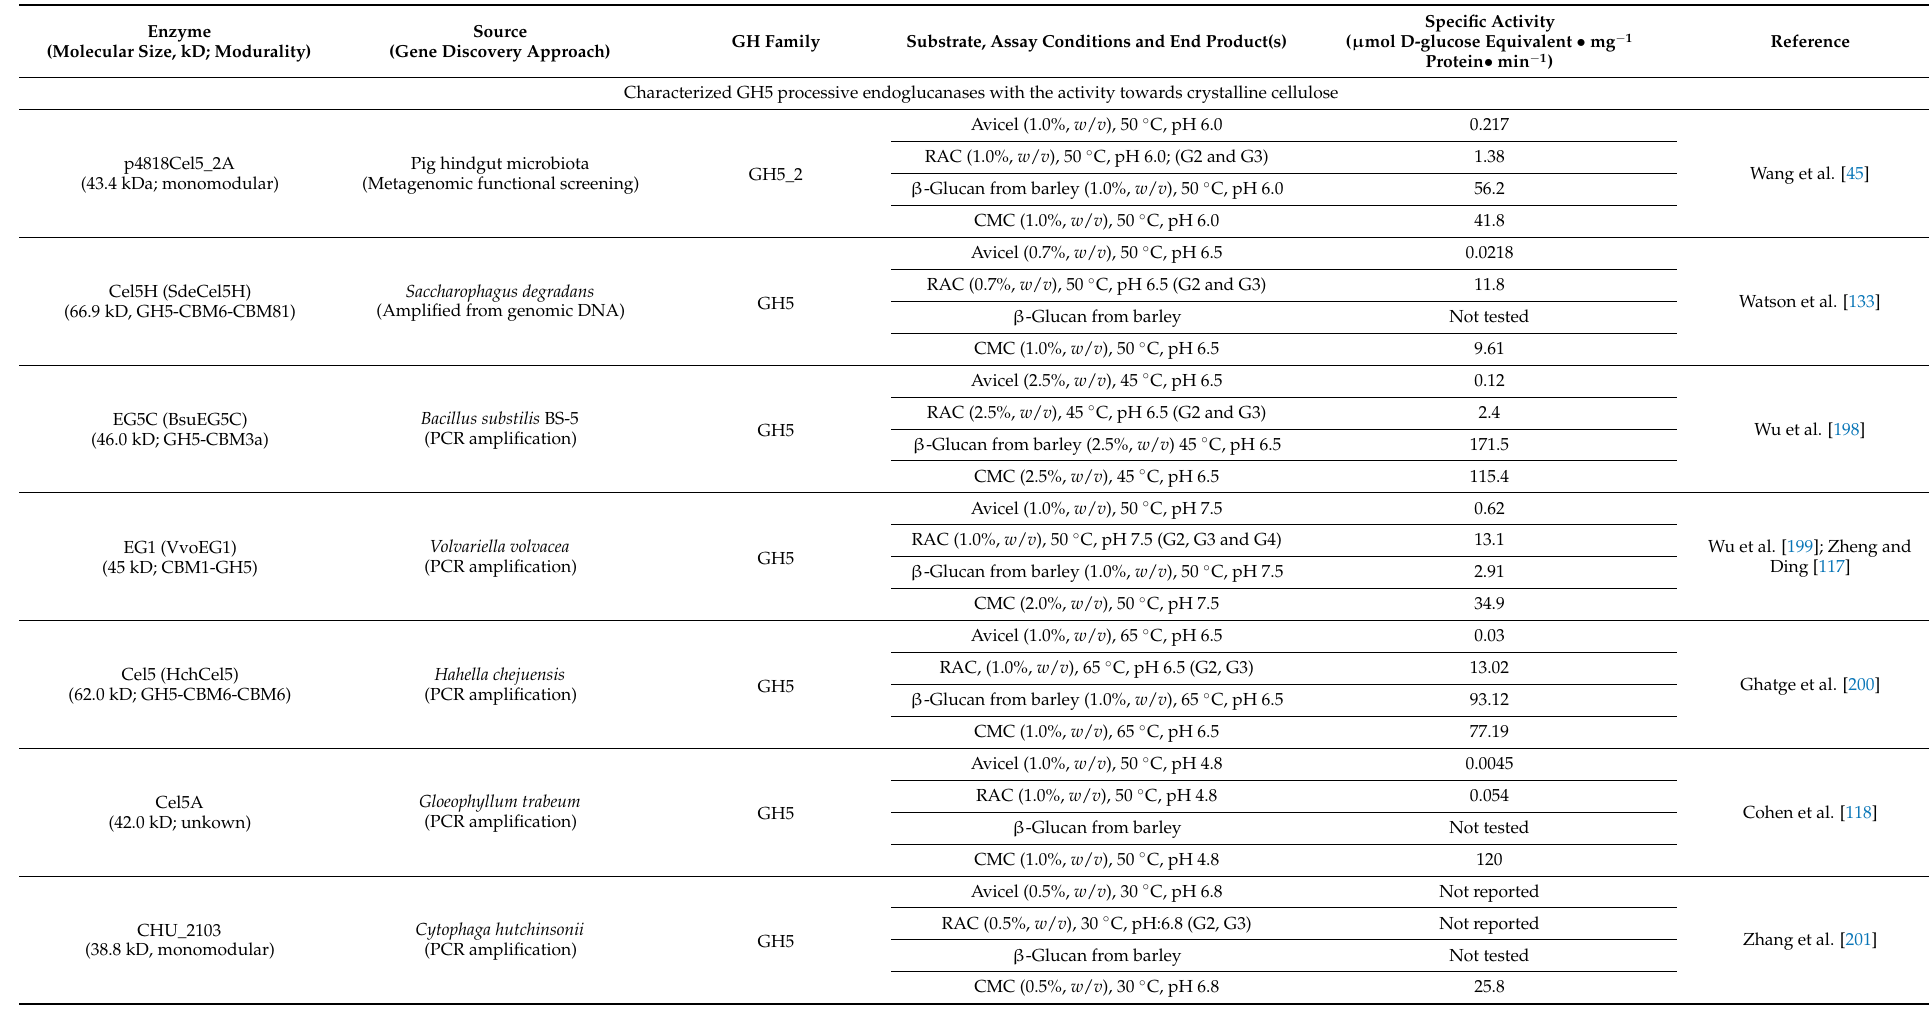
Table 1. The summary and comparison of enzyme activity for some of the characterized processive endcellulases towards their polymeric substrates. Enzyme (Molecular Size, kD;